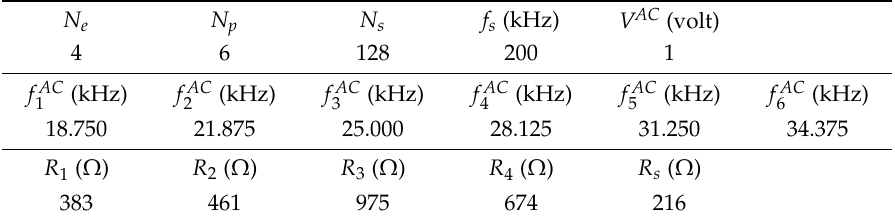
Table 1. Parameters of the proof-of-concept experiment, signal frequencies and resistors used.